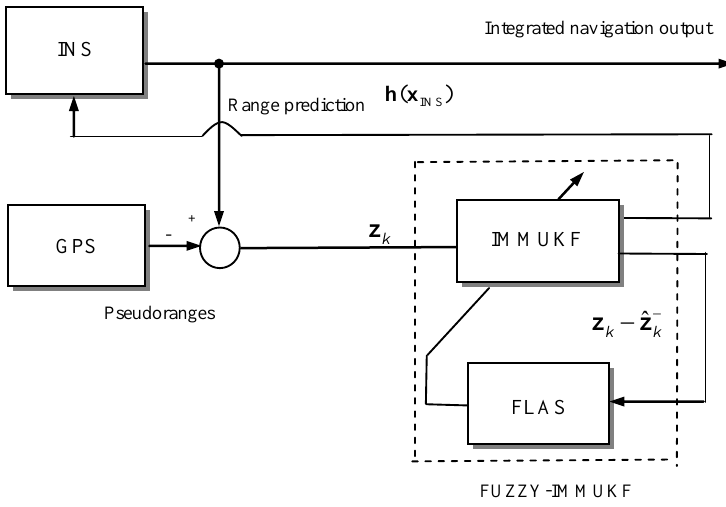
Figure 4. Configuration of the tightly-coupled feedback integrated navigation using the proposed